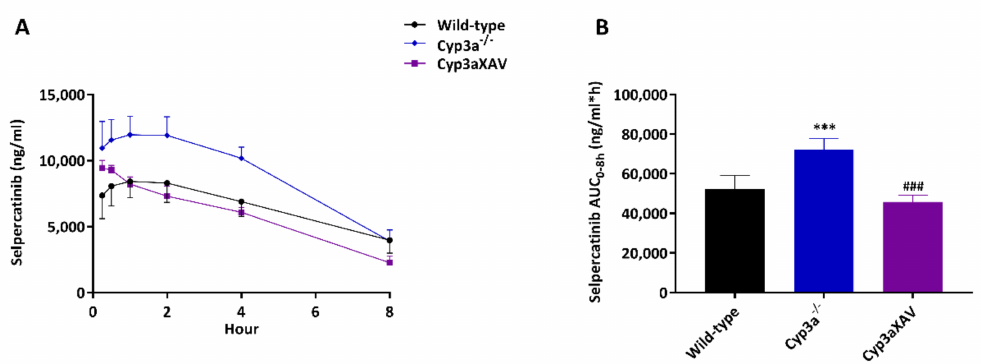
Figure 8. Plasma concentration–time curves ( A ) and plasma AUC 0–8h ( B ) of selpercatinib in female wild-type, Cyp3a -/- and Cyp3aXAV mice 8 h after oral administration of 10 mg/kg selpercatinib. Data are given as mean ± S.D. (n = 6–7). *, p < 0.05; **, p < 0.01; ***, p < 0.001 compared to wild-type mice; #, p < 0.05; ##, p < 0.01; ###, p < 0.001 compared between Cyp3a -/- and Cyp3aXAV mice. Statistical analysis was applied after log-transformation of linear